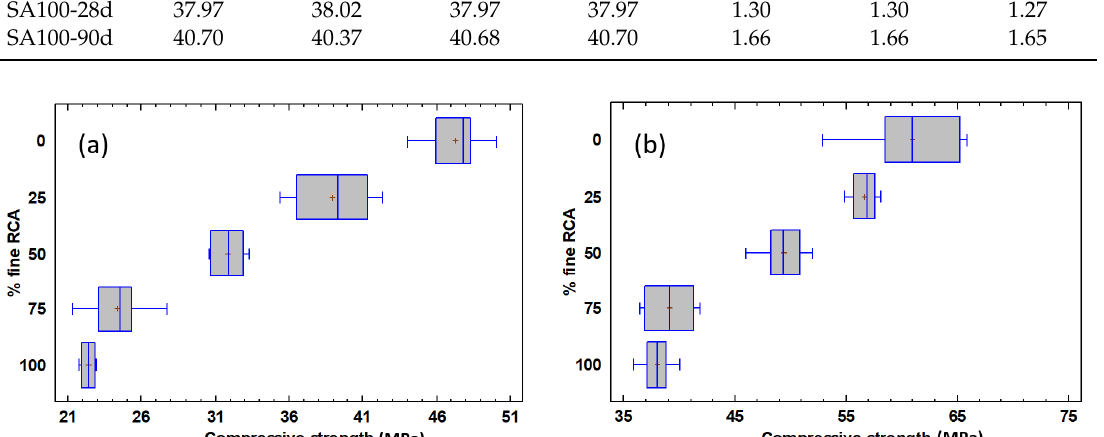
Table 9. p -value for the normality tests of the compressive strength of each mixture at each age.